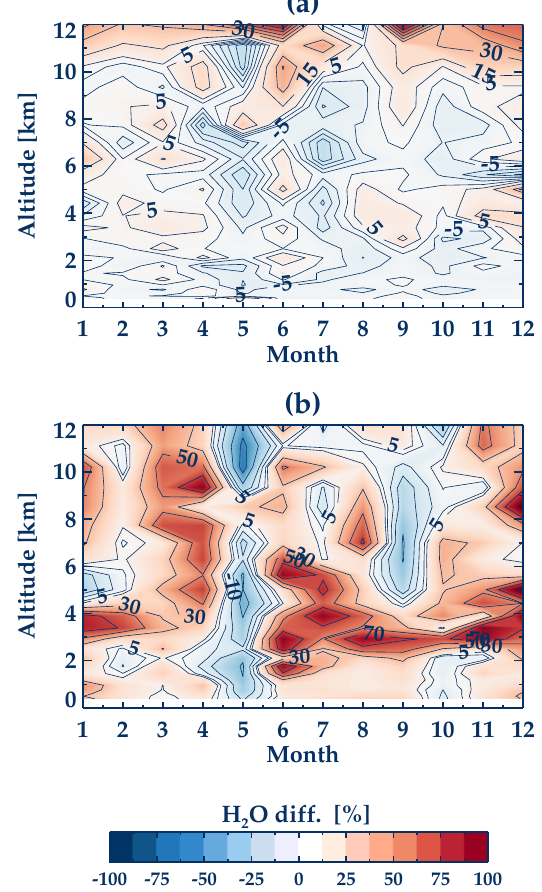
Figure 2. (a) Multi-annual and monthly mean percentage differ- ences between radiosonde and FPH H 2 O measurements. (b) Multi- annual and monthly-mean percentage differences between NIWA– UKCA output and FPH H 2